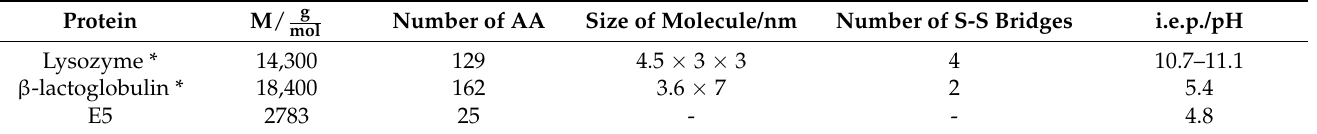
Table 5. Molecular properties of applied proteins. *